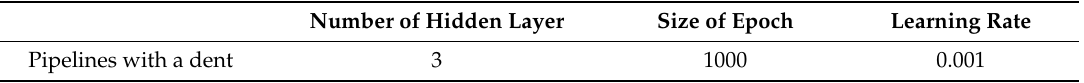
Table 6. Summary of the defined hyper-parameters for deep neural network model.